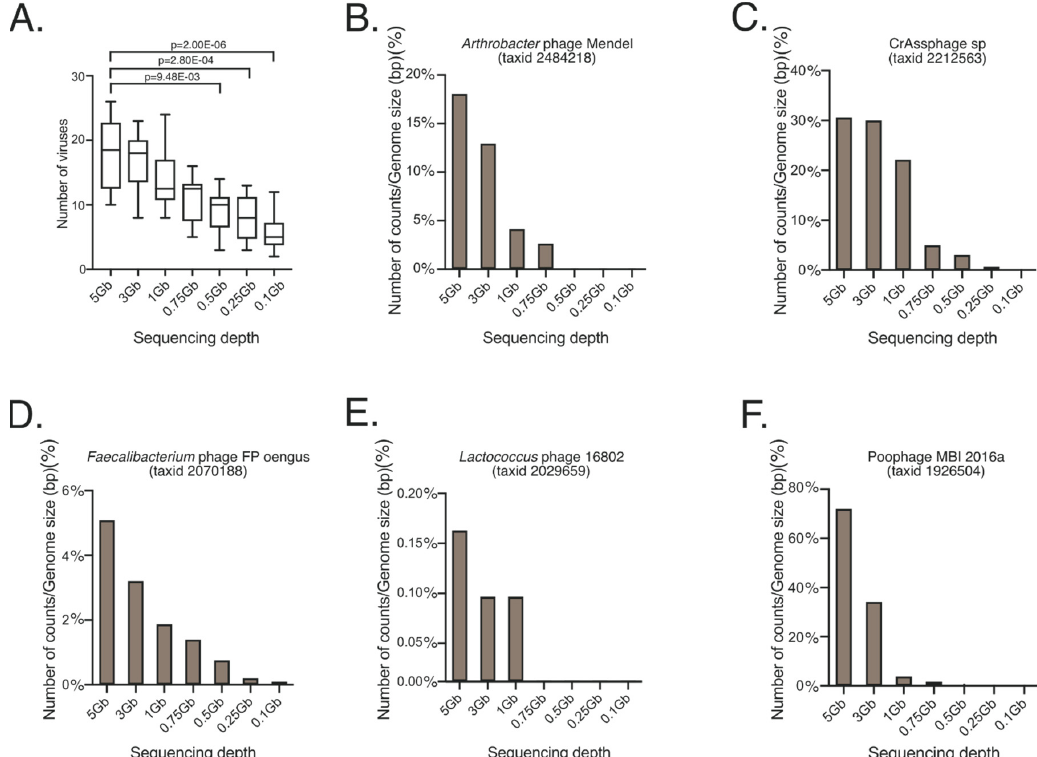
Figure 5. Viruses identified in healthy individuals at various sequencing depths including 5 Gb